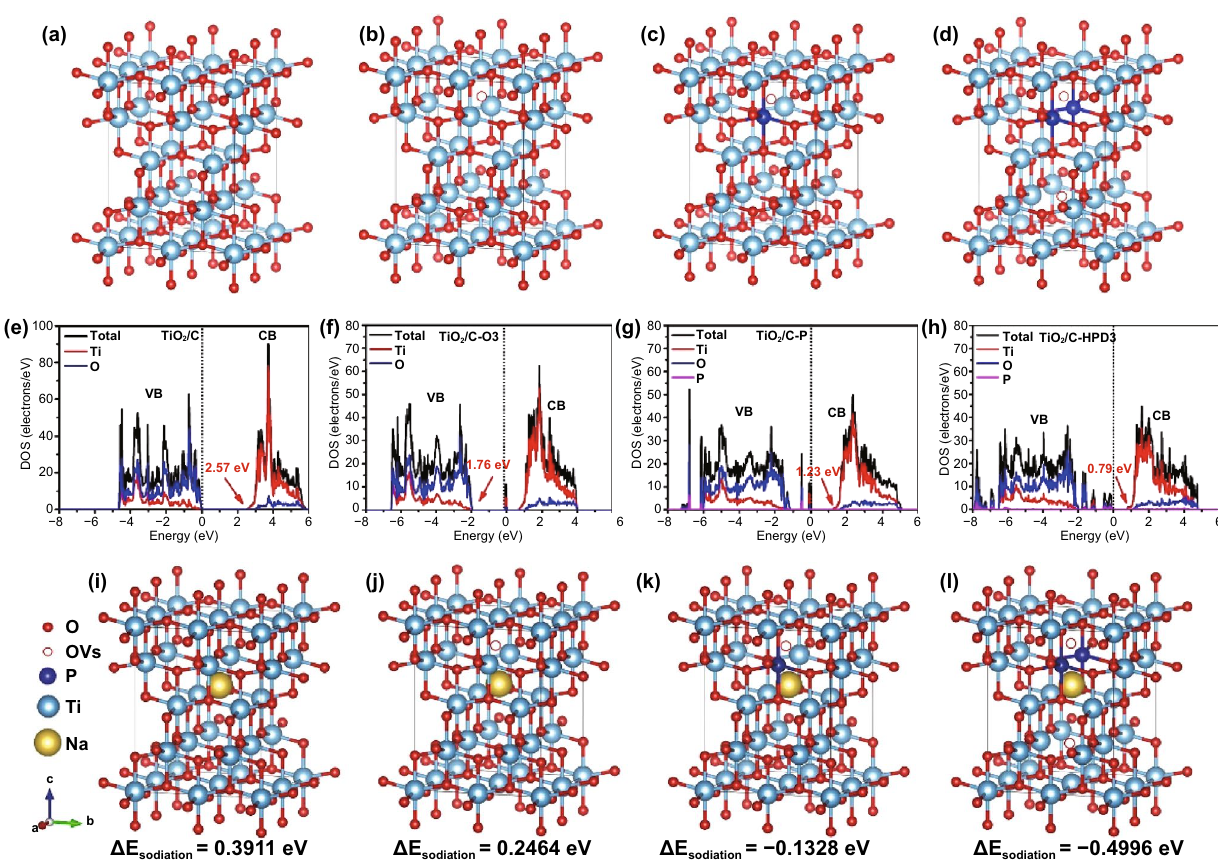
Fig. 4 a‑d The structural models, e–h density of states (DOS) analyses, i‑l Na ion intercalation model of TiO 2 /C, TiO 2 /C-O3, TiO 2 /C-P, and